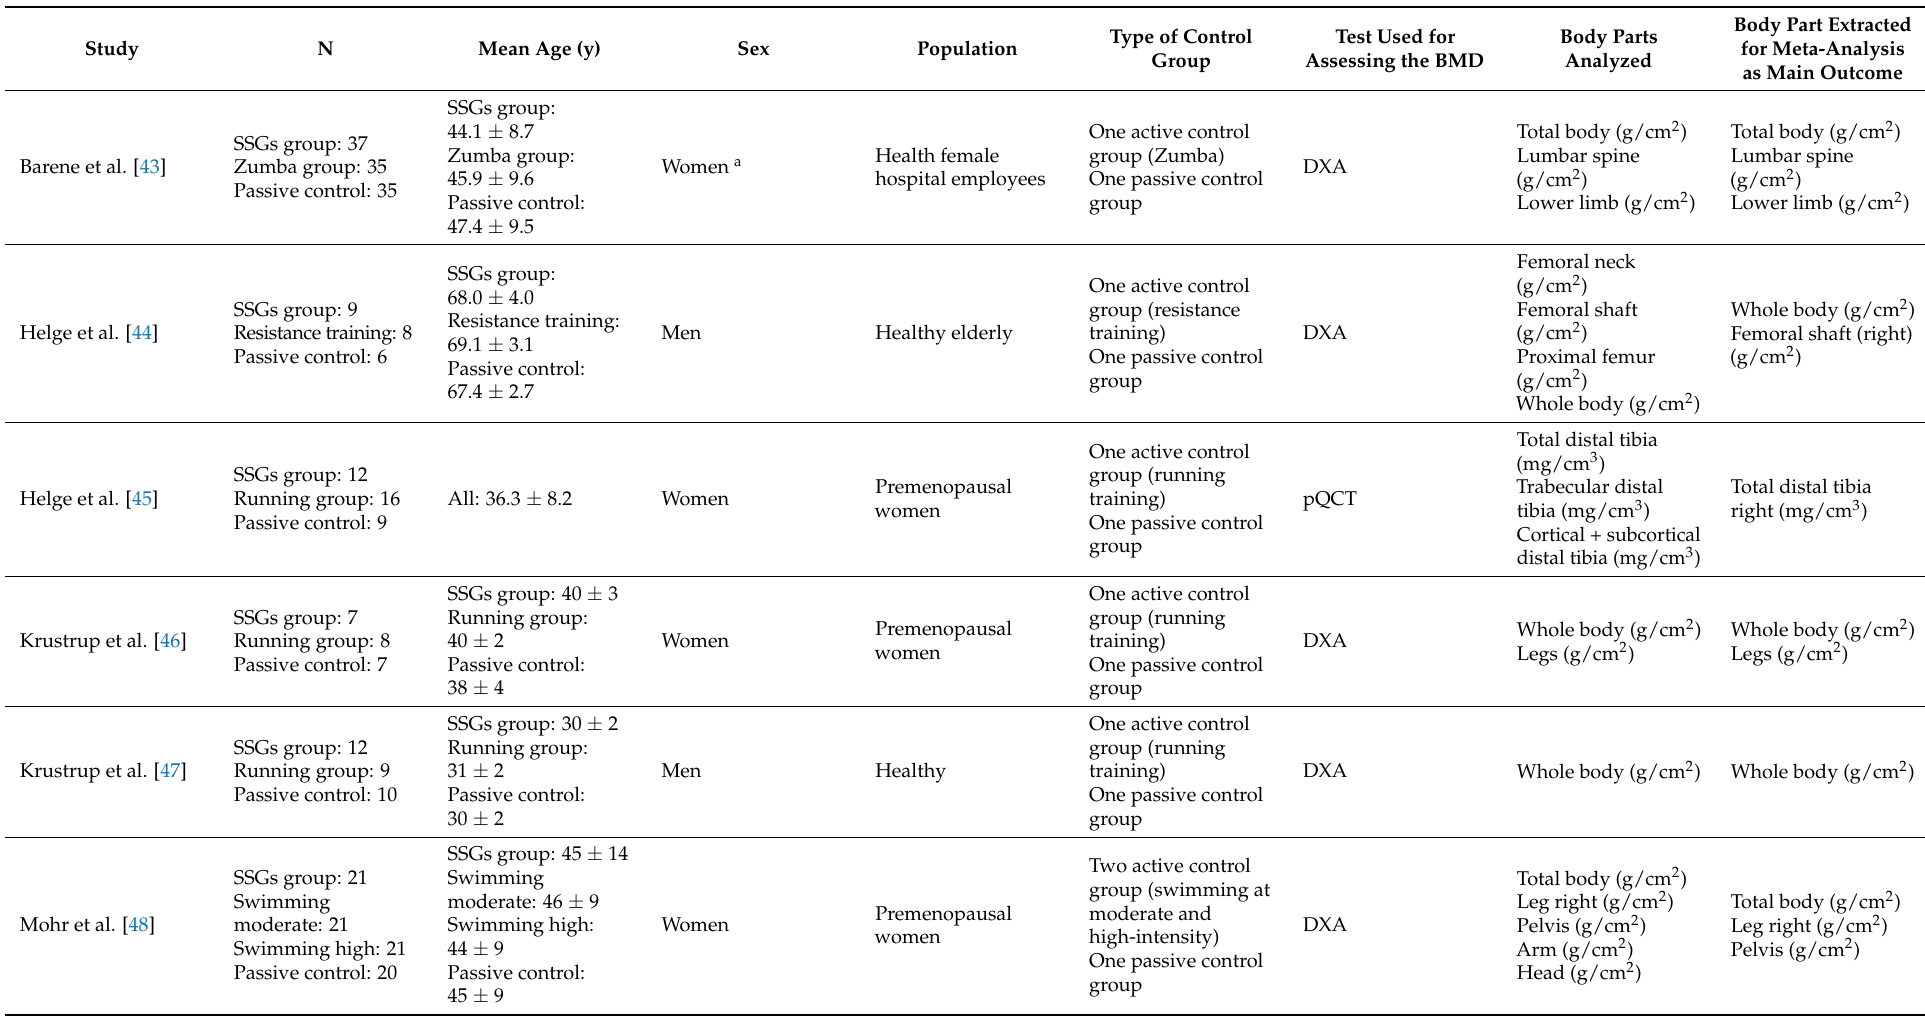
Table 2. Characteristics of the included studies and outcomes